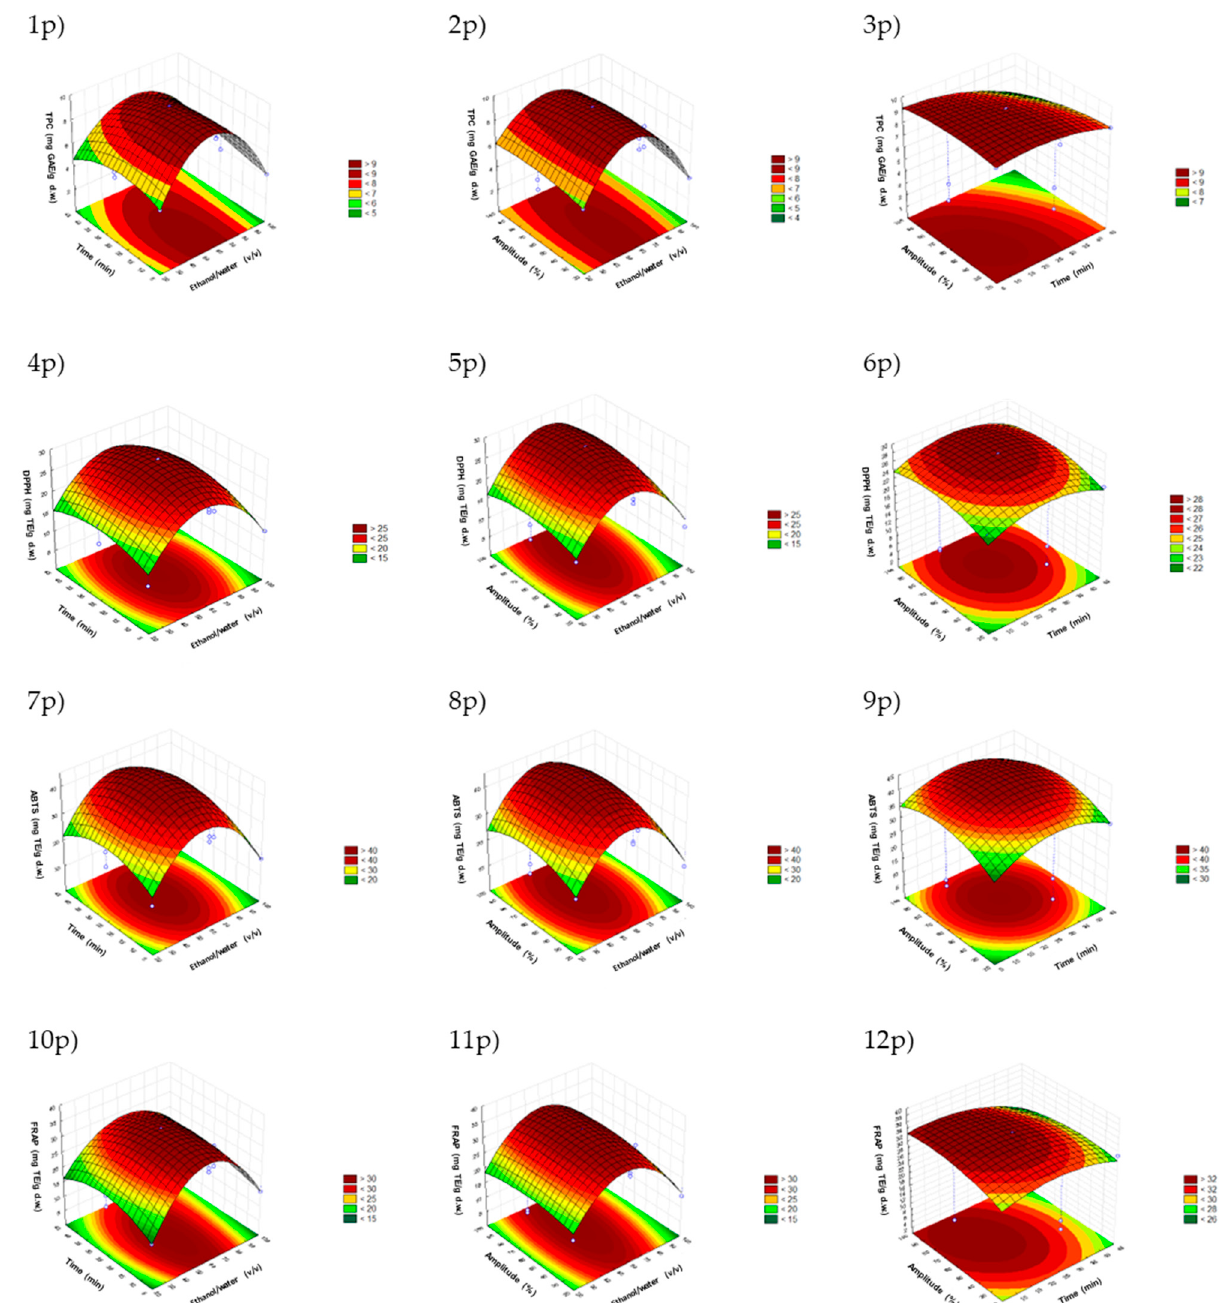
Figure 2. Response surface graphs of sonotrode model (1p–12p) showing the combined effects of the process variables: ethanol/water ( v/v ), time (min), and amplitude (%) for TPC (mg GAE/g dw), for DPPH antioxidant assay (mg TE/g dw), for ABTS antioxidant assay (mg TE/g dw), and for FRAP antioxidant assay (mg TE/g dw).